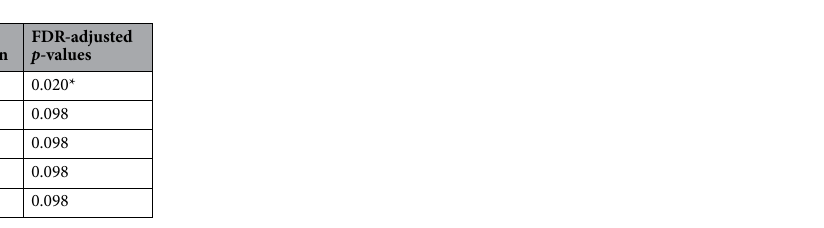
Parameters Correlation